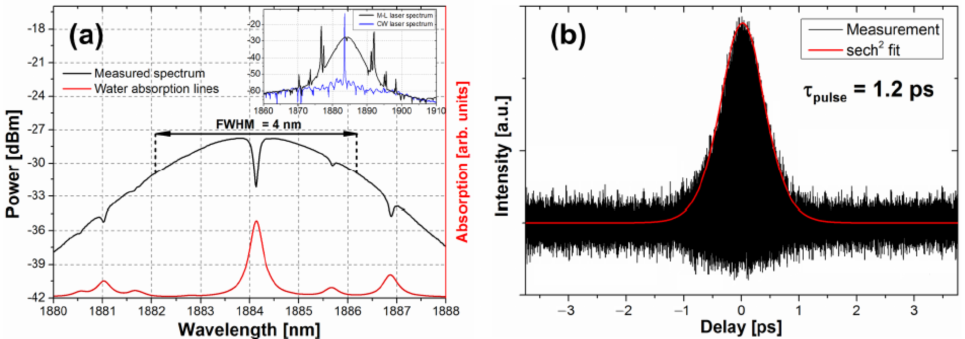
Figure 19. ( a ) Measured optical spectrum and ( b ) autocorrelation trace of the laser system. Reprinted with permission from